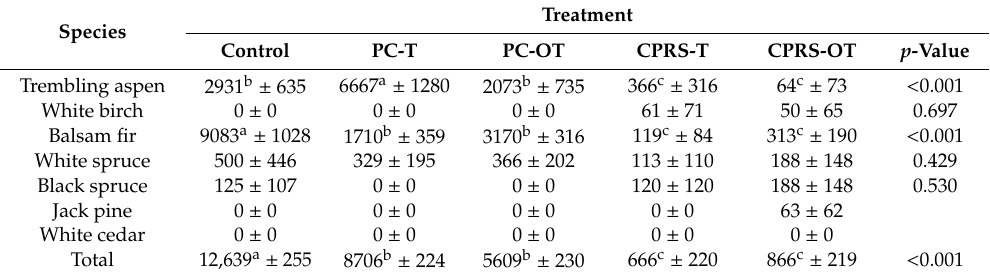
Table 4. Mean regeneration density ± N ha − 1 ± Standard error of seedlings ± ≤ 1 cm DBH on and o ff machinery trails across treatments and species 7 to 19 years after treatment in the boreal mixed-woods of eastern Canada. On a given line, groups with di ff erent letters di ff er significantly based on Tukey HSD comparisons ± α =